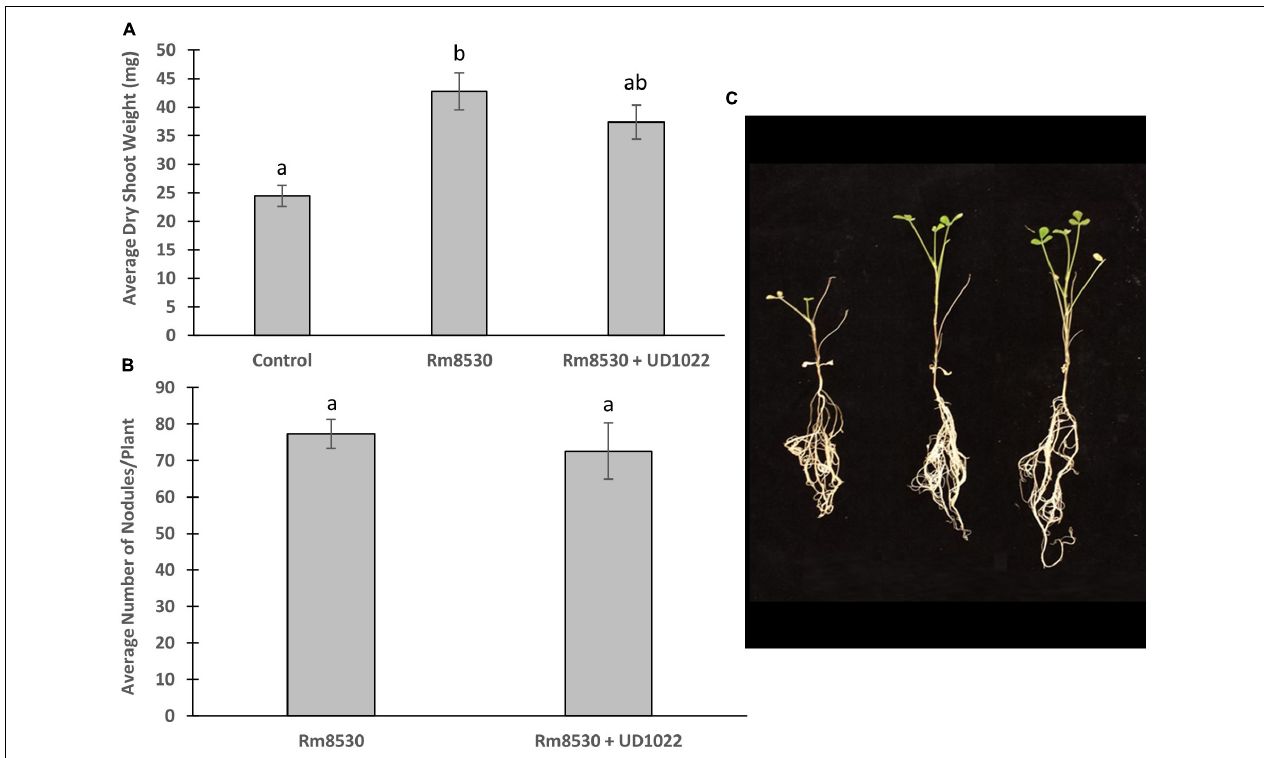
FIGURE 1 | Co-inoculated plant growth and nodulation. (A) Average plant dry weight of Rm8530 treated control plants and co-inoculated Rm8530 & UD1022 plants did not differ statistically ( p -value of 0.06). (B) There was no statistical difference between average counts of nodules between treatments ( p -value of 0.59). (C) Overall plant growth of both treatments was greater than control (first plant), but no differences were observed between Rm8530 treatment (second plant) and Rm8530 & UD1022 co-inoculation (third plant).